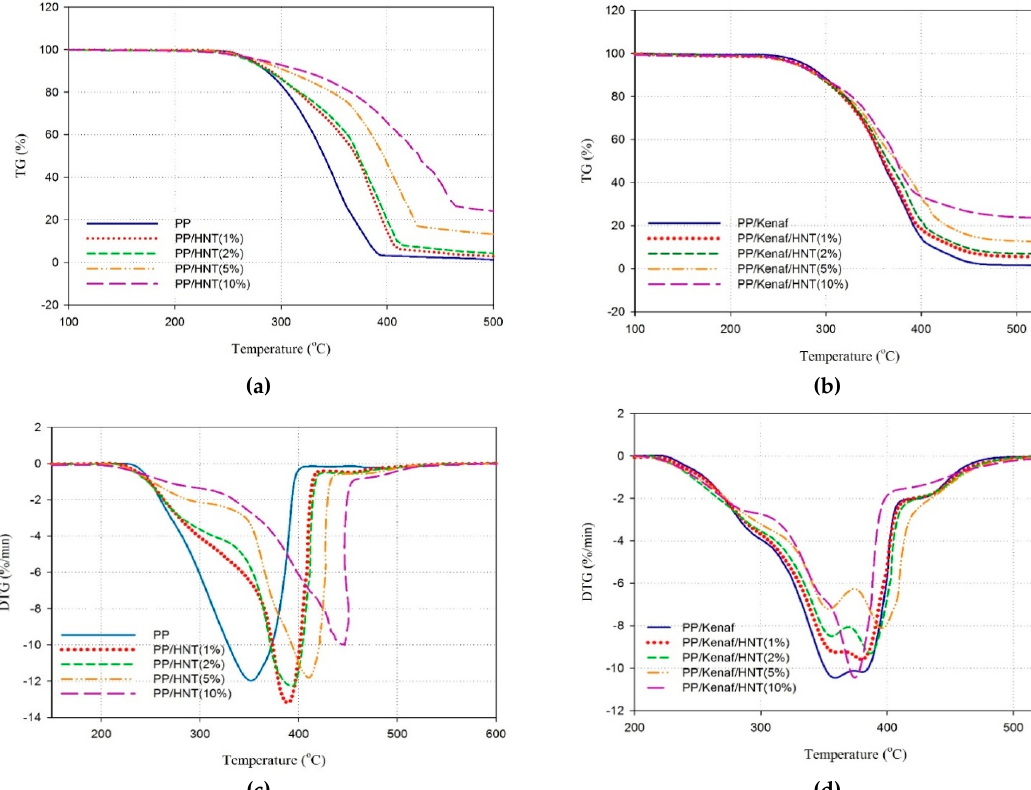
Figure 7. The thermo-oxidative degradation analysis curves for PP and its NCs in air atmosphere ( a , b ) weight loss and ( c , d ) derivative of weight loss. Table 4. Characteristic temperatures of the thermo-oxidative decomposition of the NCs.